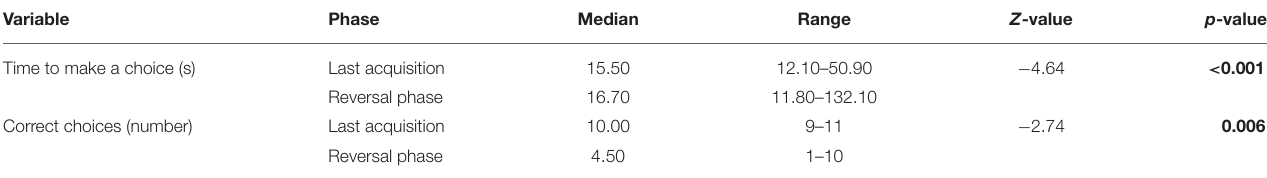
TABLE 2 | Differences in performance during last acquisition and reversal phases in the reversal learning test.